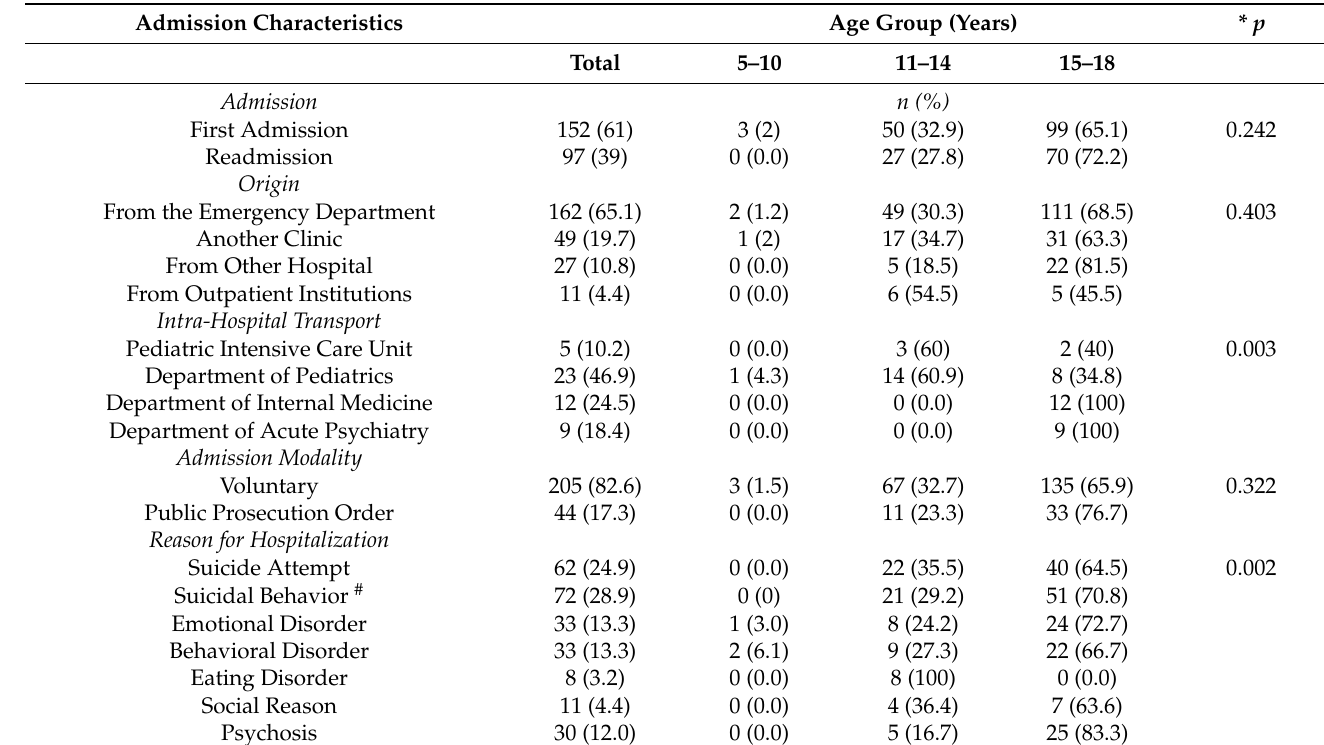
Table 1. Characteristics of acute mental health crisis episodes needing hospitalization in Pediatric Psychiatric Clinic.